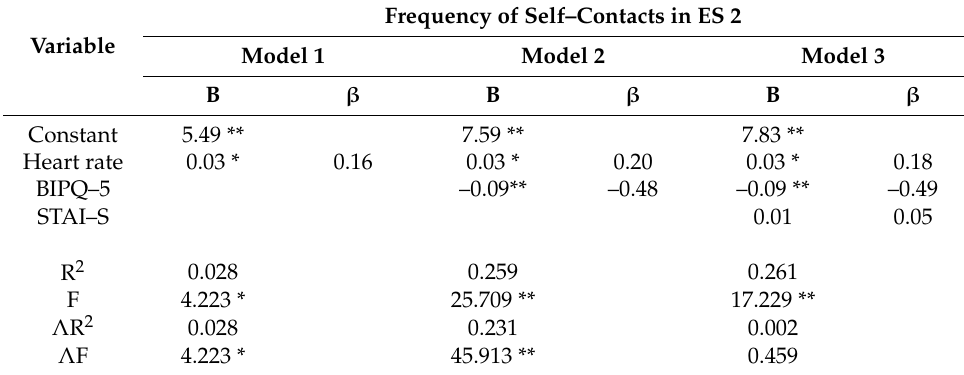
Table 5. Hierarchical Multiple Regression Prediction Self–contacts in ES 2 from health rate, STAI–S y